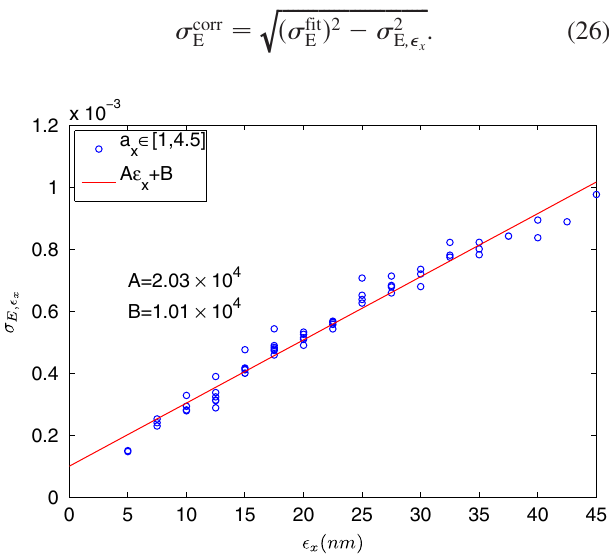
FIG. 9. (Color) Additional spectrum broadening, (cid:1) E function of the horizontal electron beam emittance (cid:3) fit to a linear function of (cid:3) the plot.